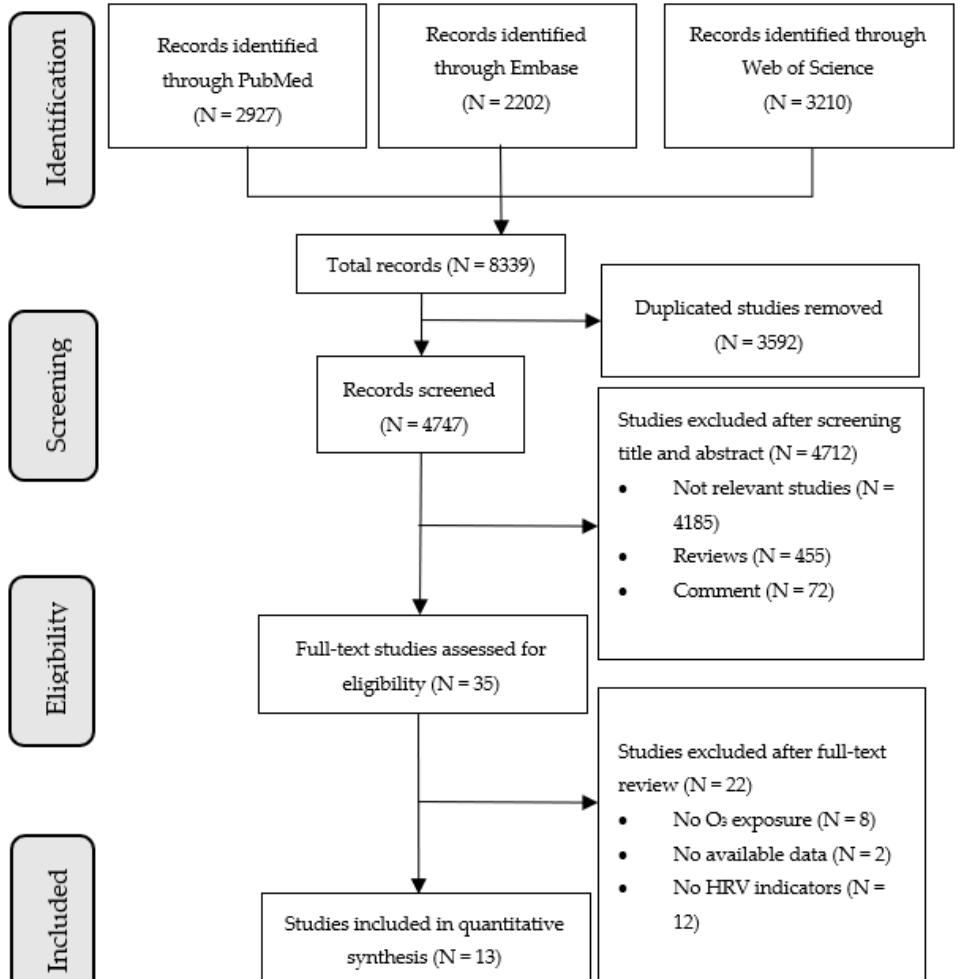
Figure 1. Flow chart of study selection.